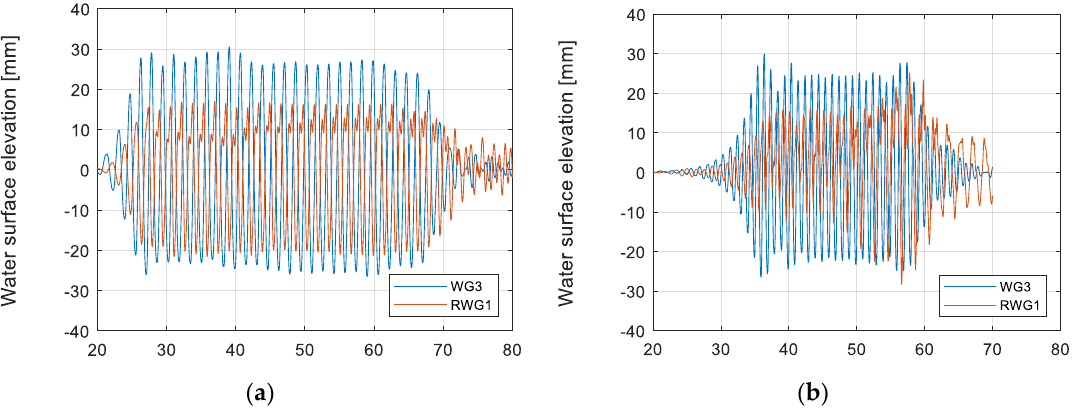
Figure 15. Water surface variation for 30 nonlinear regular waves measured by WG2 and RWG1 ( a ) d = 0.625 m, H = 0.6 m, and T = 1.6 s, ( b ) d = 0.625 m, H = 0.6 m, and T = 1.0 s.